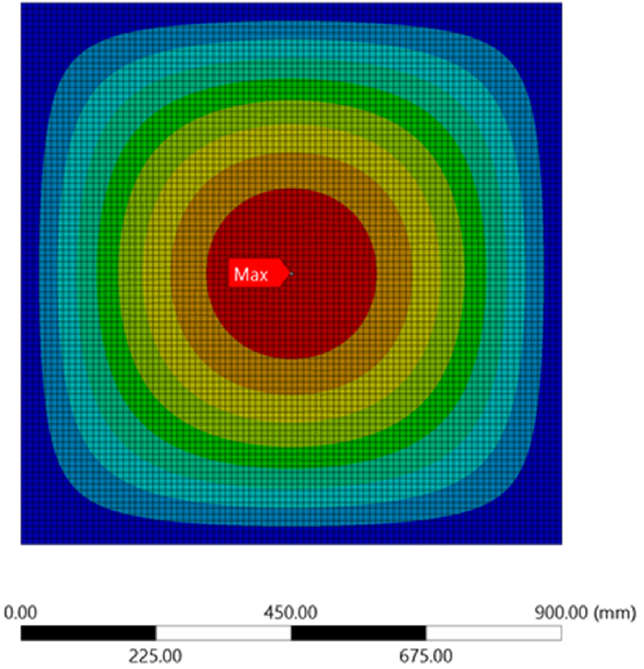
Figure 7. Displacement contour for the unperforated steel plate.